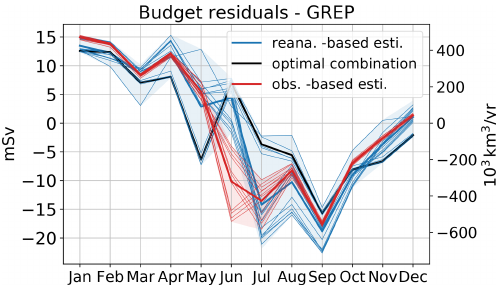
Figure 10. Mean annual cycles of different realizations of the bud- get residuals (all 1993–2018; reanalysis based: blue lines, obser- vation based: red lines) and the optimal combination yielding the smallest NRMSE value (black line).